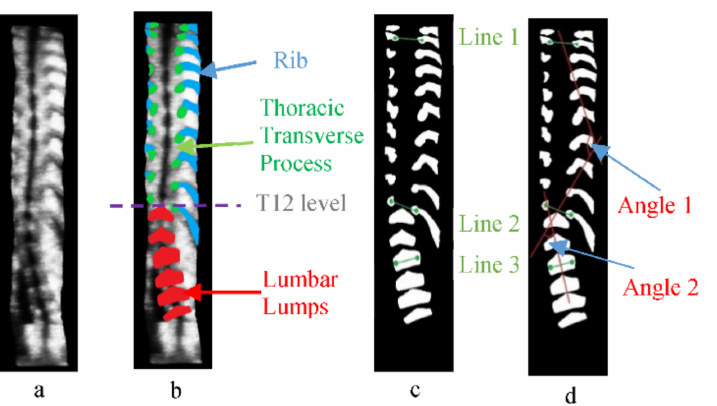
Figure 2. Ultrasound curve angle (UCA) measurement of ( a ) original ultrasound spine image and ( b ) marked lateral bony features with three types of anatomical features. ( c , d ) Illustration of methodology.